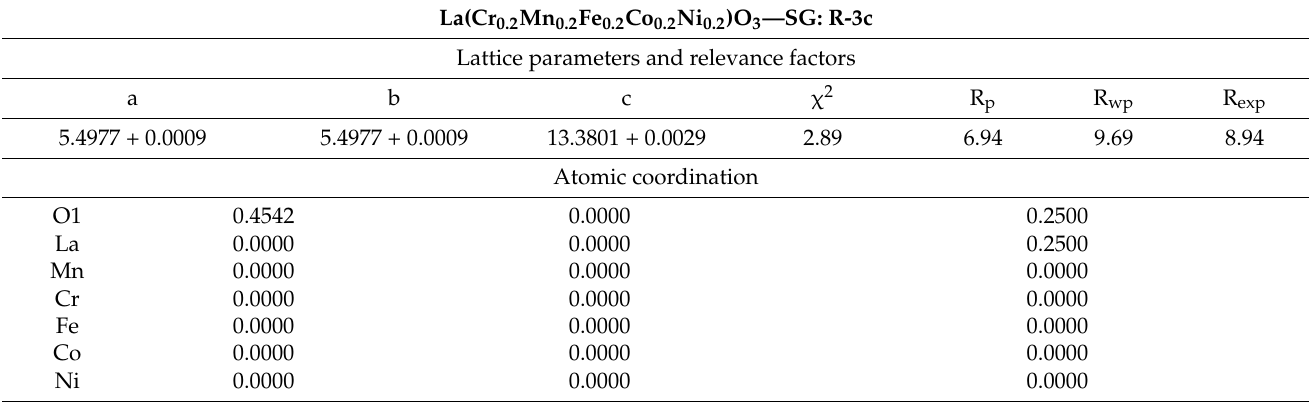
Table 2. Lattice parameters, relevance factors and atomic coordination of the La-CMFCNO, Nd-CMFCNO and LN-CMFCNO ceramic